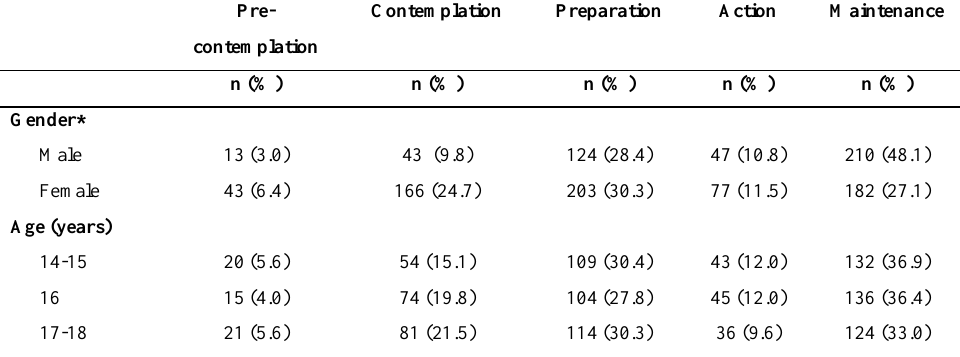
Table 1. Distribution (%) of adolescents across each stage of change in physical activity-related behavior, broken down by gender and age (Florianópolis, Santa Catarina, Brazil.